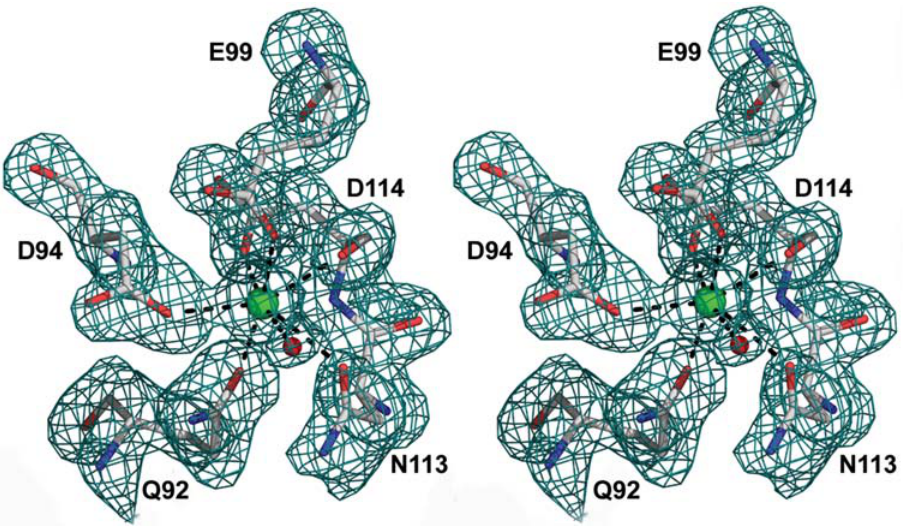
Figure 5. Stereo view of Ca 2 + -coordination sphere. Black dashed lines indicate the coordination bonds. The Ca 2 + ion (green) is coordinated with a water molecule (red), Gln92 O e 1 , Asp94 O d 2 , Glu99 O e 1 , Asn113 O d 1 and Asp114 O and O d 1 . This diagram was generated using PyMOL [41].